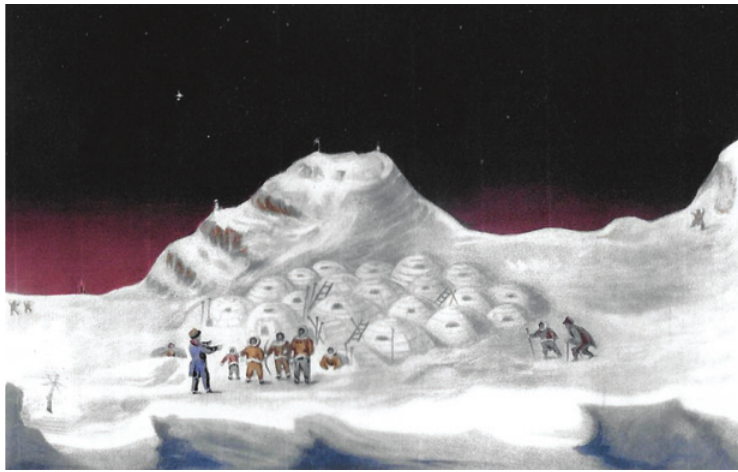
Figure 7. Inuit village of igloos. Sourc e: Ross, Second Voyage ,